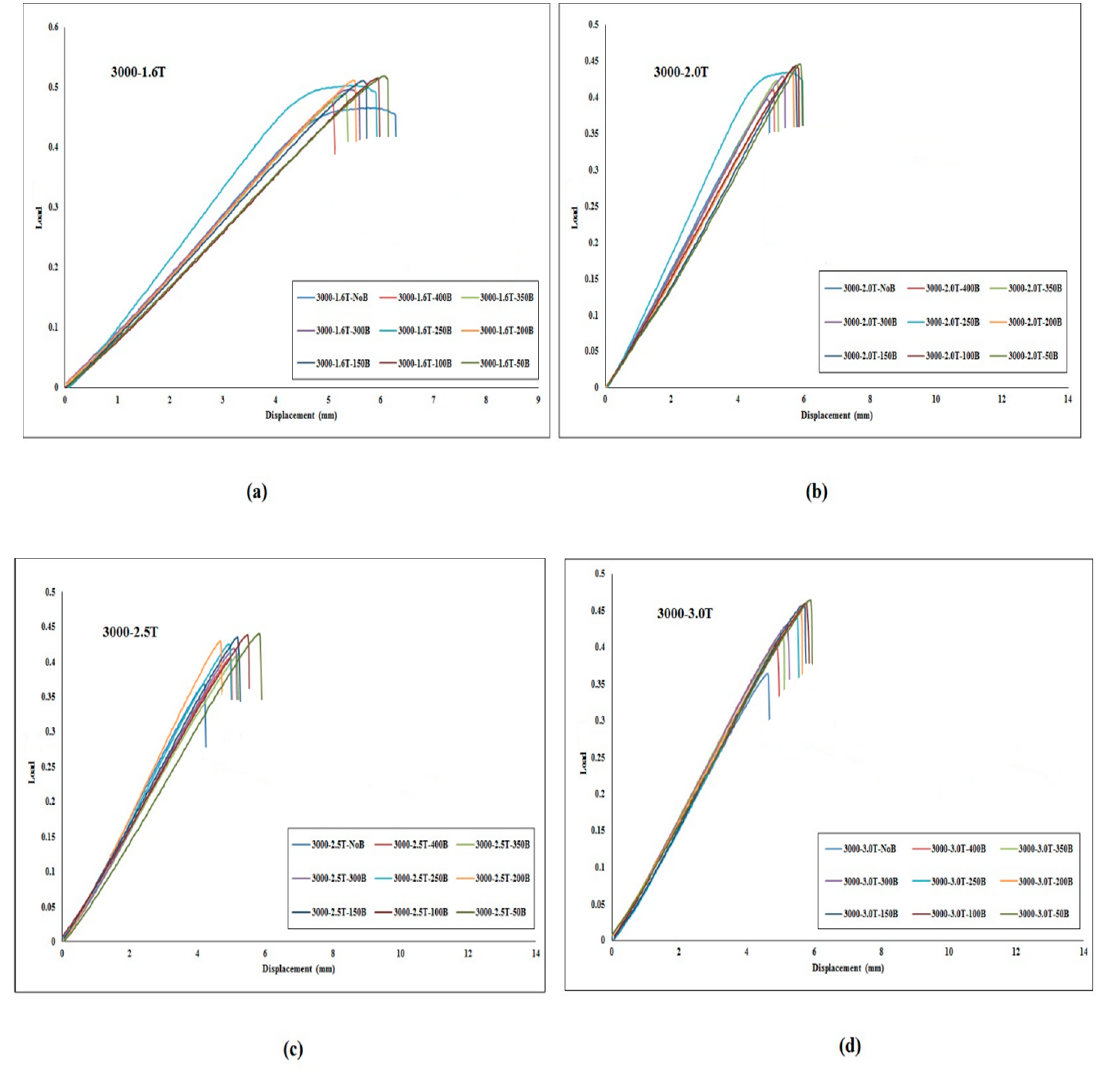
Figure 13. Normalised load-displacement diagrams of the FE results for: ( a ) 3000L-1.6T, ( b ) 3000L-2.0T, ( c ) 3000L-2.5T, and ( d ) 3000L-3.0T models.